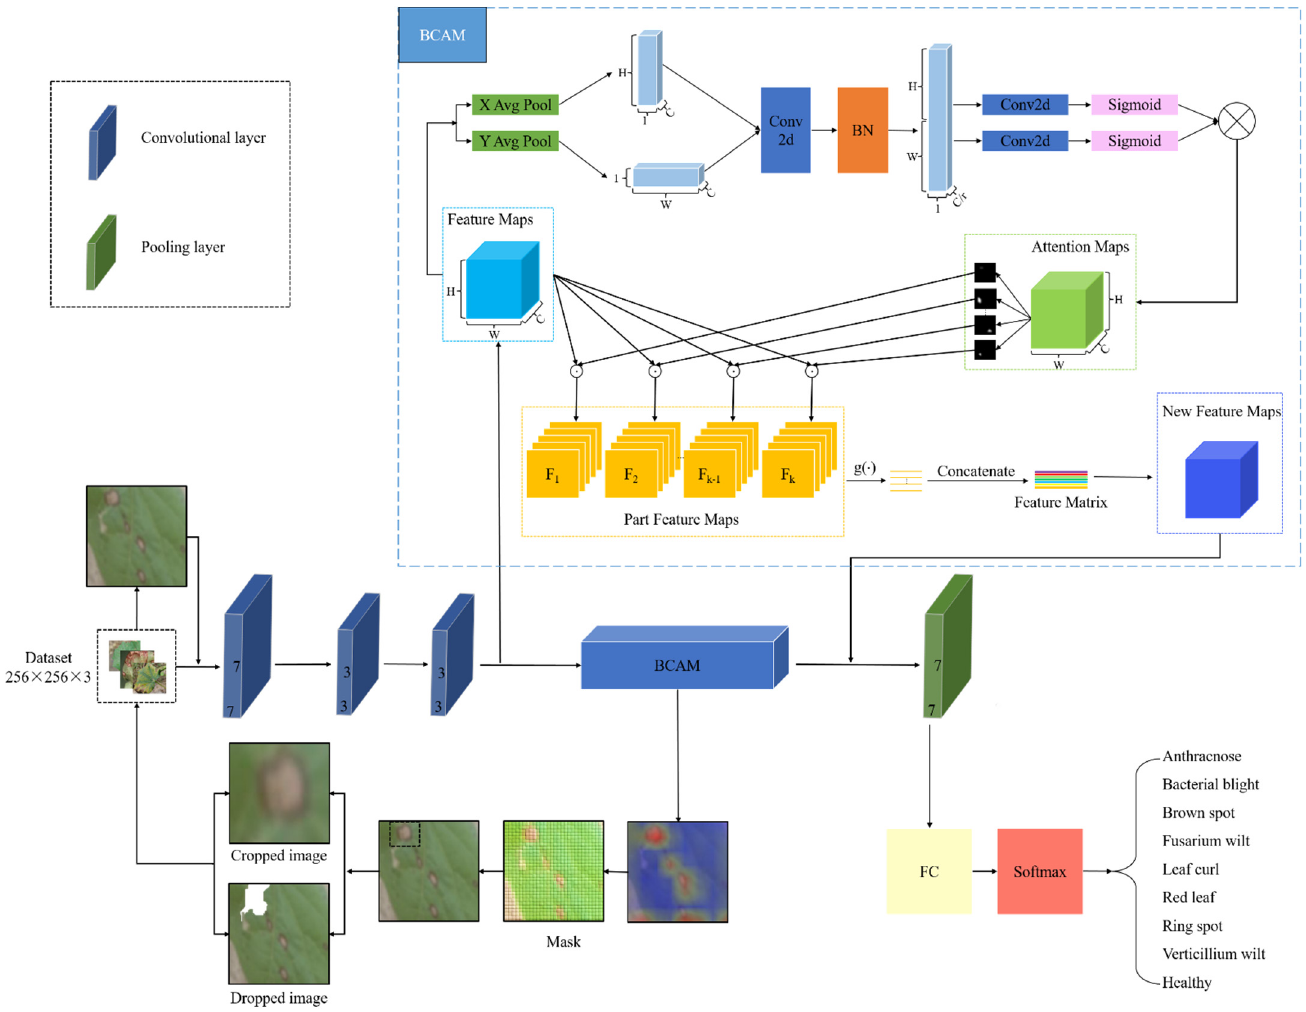
Figure 5. Identification model of cotton leaf disease based on bilinear coordinate attention-enhancement module, where ⊙ denotes the element-by-element multiplication of two tensors, g ( ﹒ ) is a feature extraction function, W , H , and C denote width, height, and channel size, BCAM denotes bilinear coordinate attention mechanism.